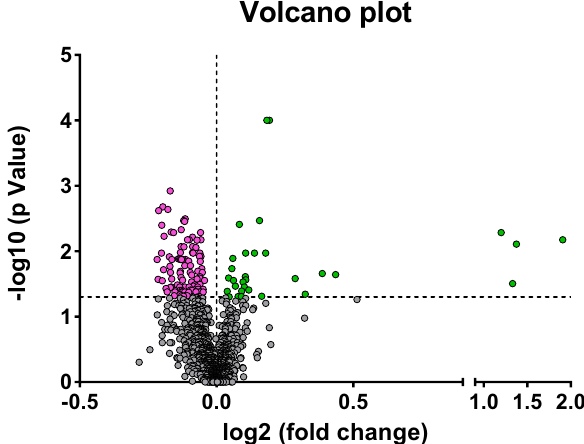
Figure 3. Volcano plot showing the most significant lipid species found by univariate analysis. The volcano plot summarizes both fold-change and t-test criteria for all lipids. It is a scatter-plot of the negative log10- transformed p-values from the t-test plotted against the log2 fold change. Grey values indicate those lipid species are not significant ( p > 0.05). Negative values (in pink) indicate downregulated lipid species, while positive (in green) values reflect upregulated lipids in women after combined physical exercise ( p <